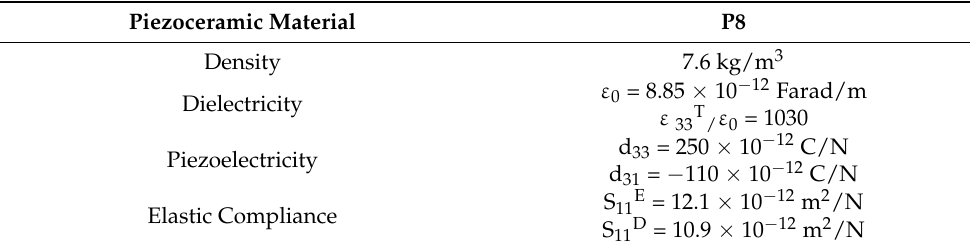
Table 1. Piezoceramic material properties.